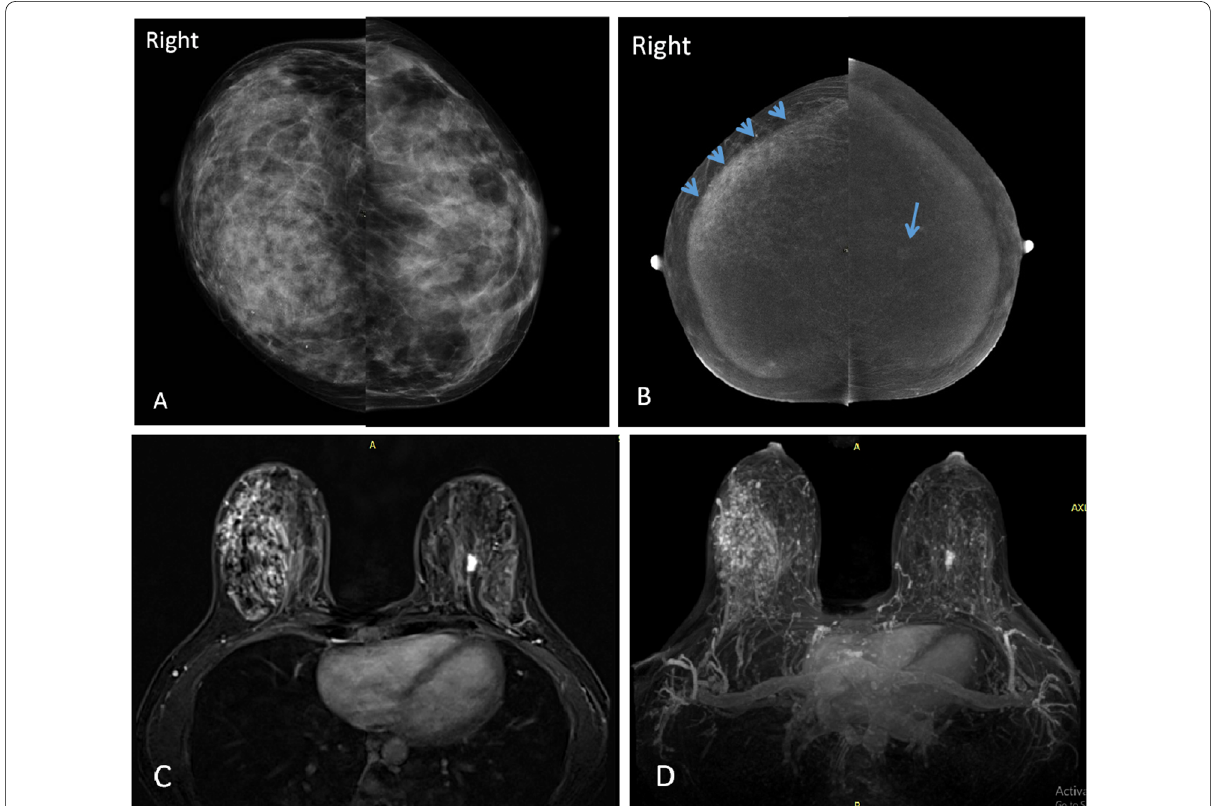
Fig. 4 A high-risk 35-year-old female with dense breasts. a Bilateral digital mammogram craino-caudal views that showed extremely dense breasts, BI-RADS zero. b Bilateral CEM, craino-caudal views that showed right breast lower outer faint asymmetrical regional non-mass contrast uptake of nodular pattern (arrow heads), BI-RADS 3 and left breast deep central faintly enhancing circumscribed focal tiny mass (long arrow), BI-RADS 2. c Early series of DCE-MRI and d Three-dimensional post-contrast maximum intensity projection images. According to MRI findings, there was right breast obvious non-mass clumped contrast uptake, suspicious of malignancy, BI-RADS 4c and left breast deep central benign looking tiny enhancing mass, BI-RADS 2. Based on MRI, biopsy was requested for the right breast non-mass enhancement, and the pathology result was benign proliferative disorder (fibrocystic changes and